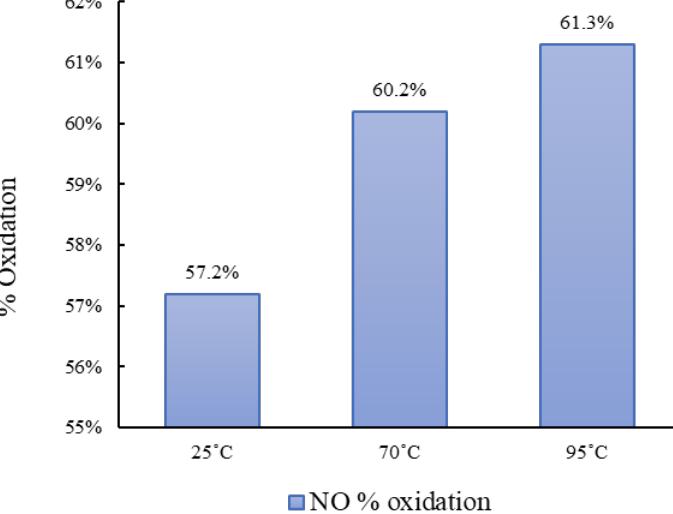
Figure 2. Effect of synthesis temperature on catalyst activity (SiO 2 /Co(OH) 2 ; [SiO 2 ] = 1 wt%, [Co] = 6 mM).